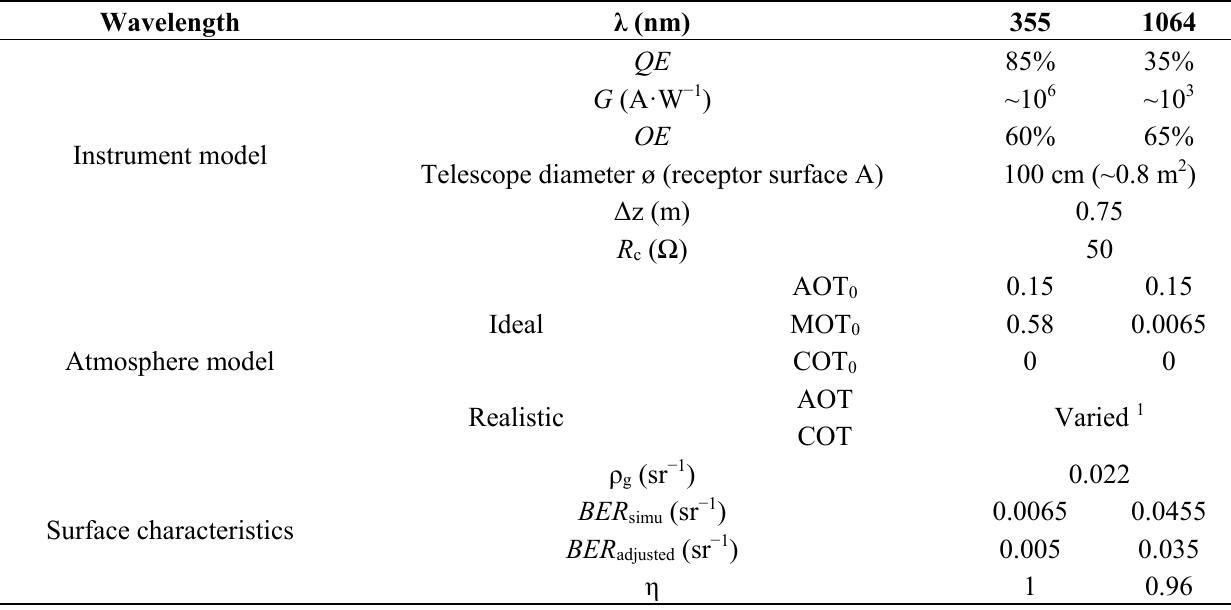
Table 1. Instrumental, atmospheric and surface parameters chosen for the simulation. Wavelength λ (nm) 355 1064